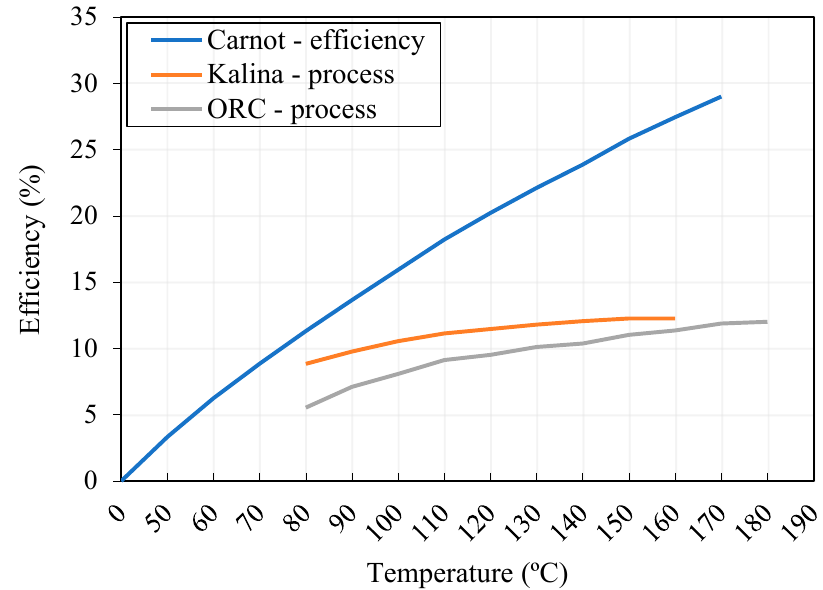
Figure 4. Efficiency variation with temperature for different cycles [51].